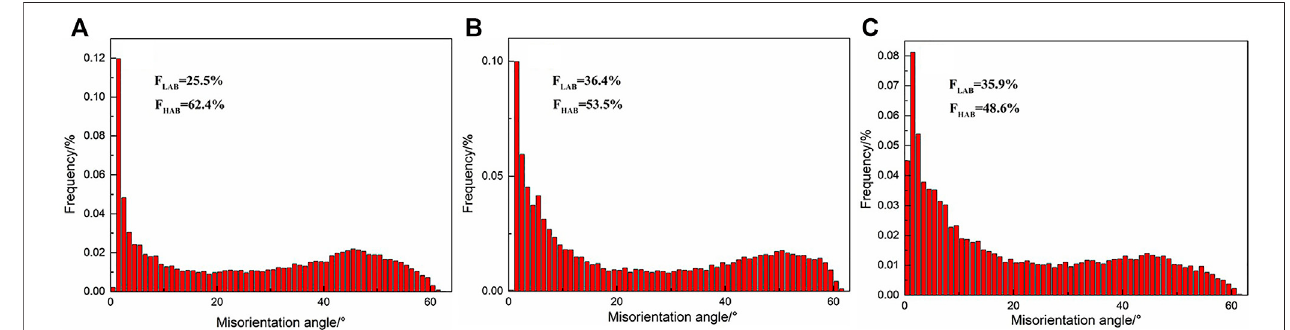
FIGURE 5 | Misorientation distribution maps and volume fraction of LAGBs and HAGBs. (A) 1#, (B) 2#, (C) 3#.